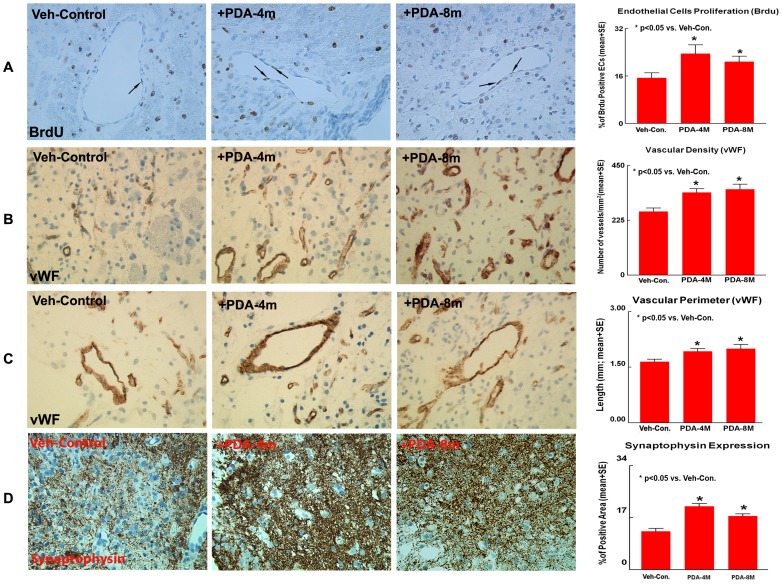
PDA-001 cell treatment promotes endothelial cell proliferation, vascular density and perimeter and increases synaptophysin expression in older rats after MCAo.Panels A–C show that PDA-001 treatment significantly increased endothelial cell proliferation (A), vascular density (B) and vascular perimeter (C) in the IBZ in older rats. Panel D shows that PDA-001 treatment significantly increased synaptophysin expression in IBZ in older rats. Error bars represent standard error of the mean (mean±SE).